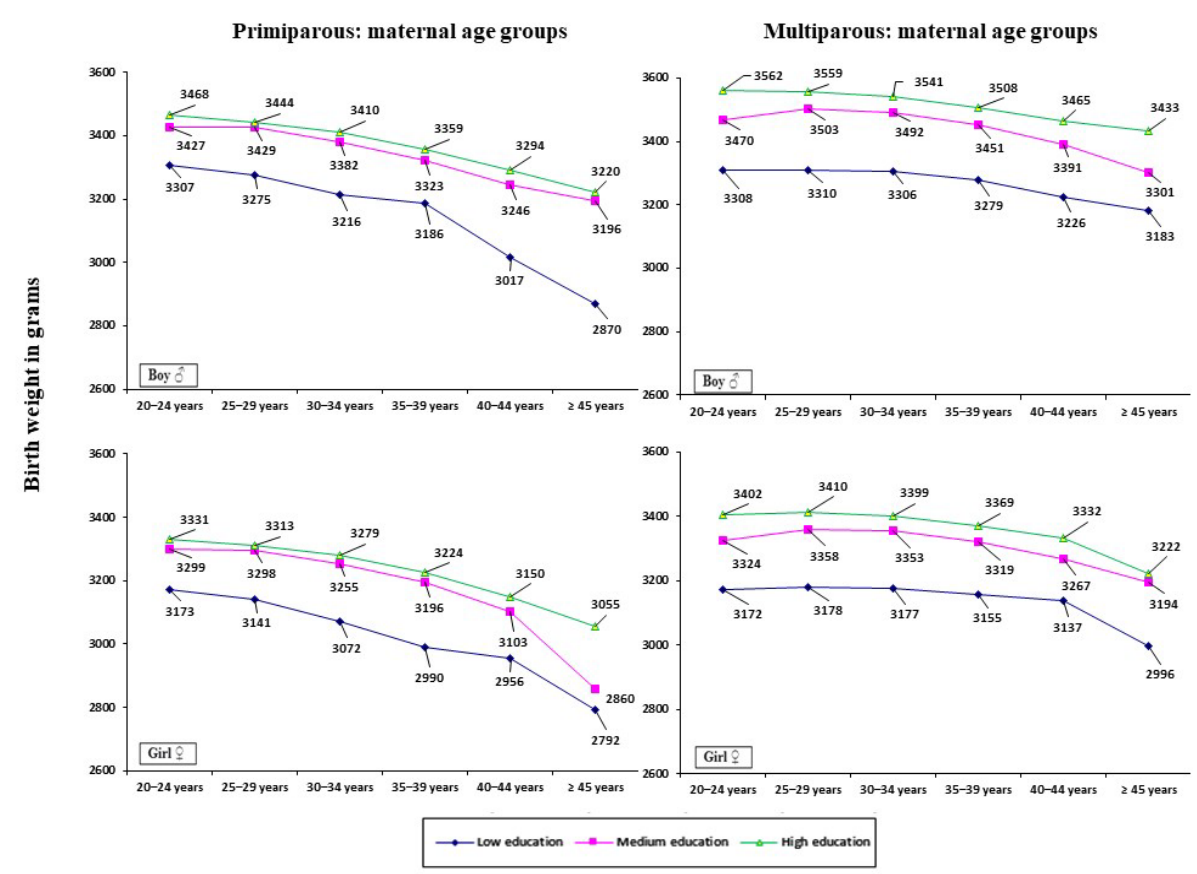
Figure 2. Birth weight based on the level of mother’s education (according to ISCED) for maternal age groups stratified by parity and sex of neonates.